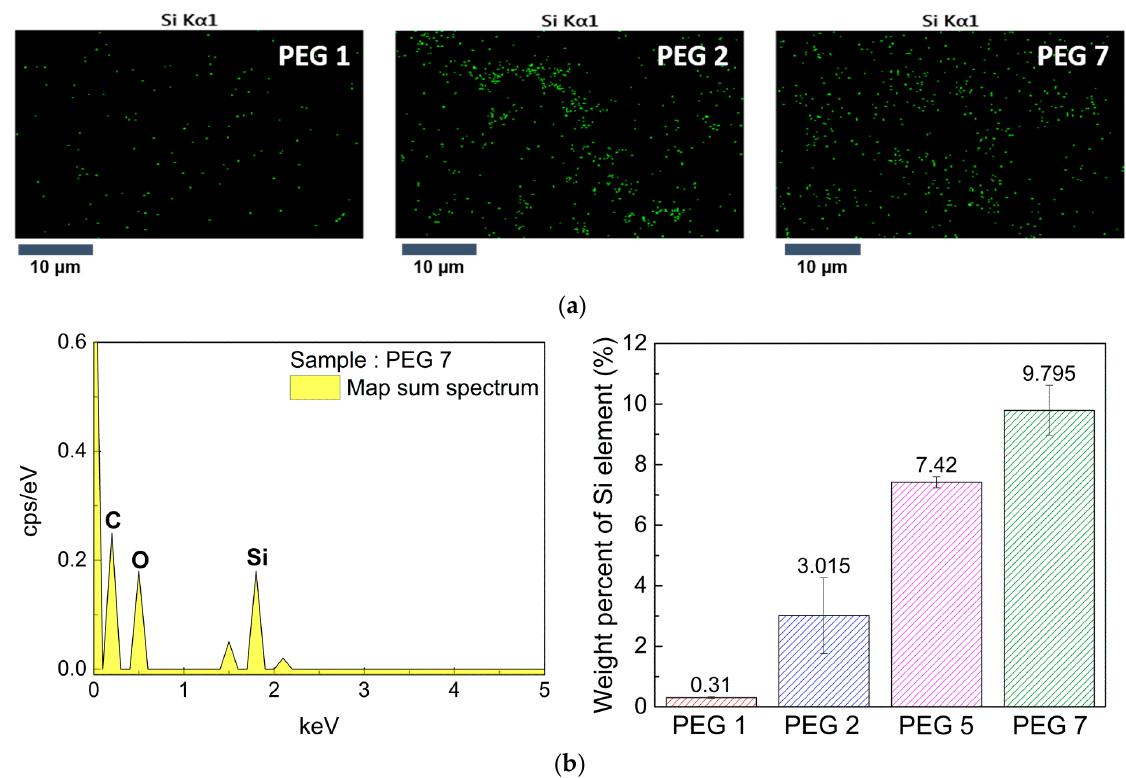
Figure 4. Distribution of Si on the cured film surface by Si mapping for the ( a ) PEG 1, PEG 2, and PEG 7 hydrogel mixtures. ( b ) Integrated area spectra and Si wt% on various crosslinked films with varying G-SiNPs contents obtained by SEM–EDS.